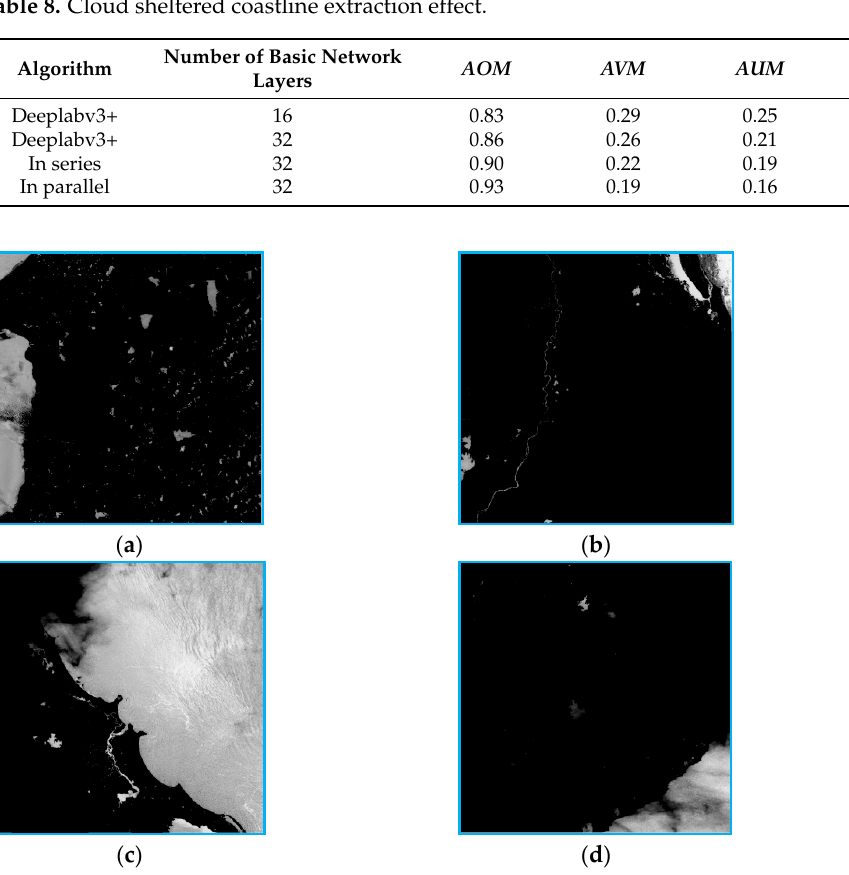
Figure 12. Effect of attention network: ( a ) short coastline; ( b ) long coastline; ( c ) multiple coastlines; and ( d ) cloud-sheltered coastline.